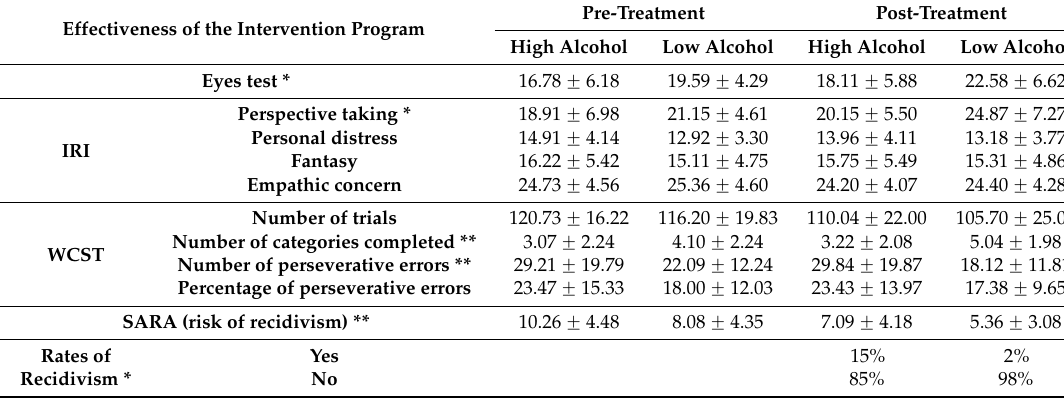
Table 2. Mean ˘ SD for empathy variables and WCST (pre vs post-treatment) for High Alcohol (HA) and Low Alcohol (LA) IPV